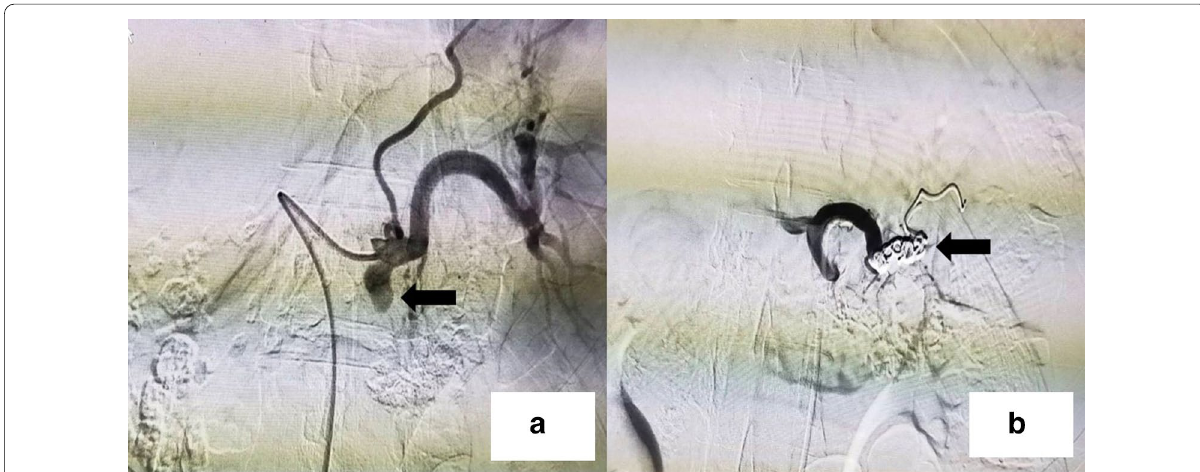
Fig. 3 DSA showing pseudoaneurysm (black arrow) in the splenic artery ( a ); DSA showing a completely knocked-off splenic artery (black arrow) without filling up the pseudoaneurysm ( b )